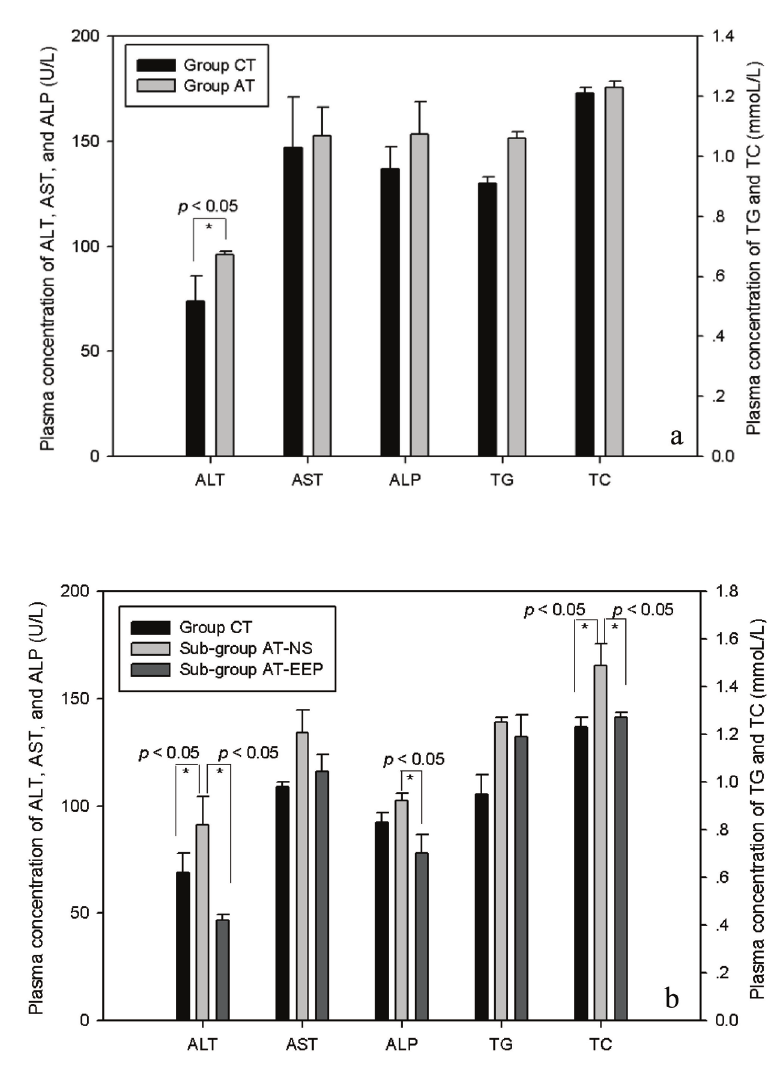
Figure 2 - Comparison of plasma parameters between different groups. Values are expressed as mean ± S.E. Group CT, control; Group AT, treated with alcohol; Sub- group AT-EEP and Sub-group AT-NS, treated with alcohol and co-administered with EEP and normal saline, respectively. a ) Comparison between groups AT and CT at the end of 7 th experimental week (n = 3). b ) Comparison between sub-group AT- EEP, sub-group AT-NS, and group CT at the end of 11 st experimental week (n = 6). * indicates significant difference at the p < 0.05